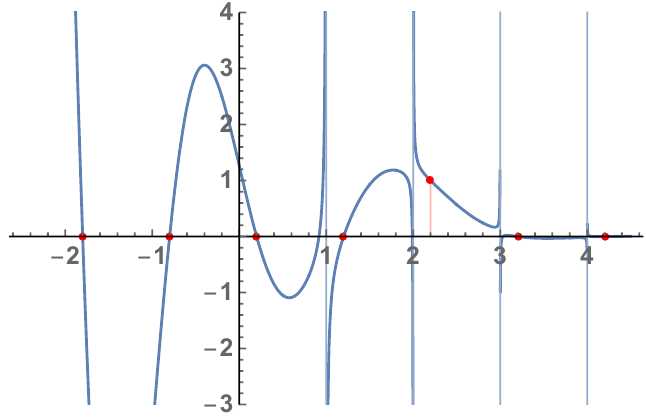
Figure 1 . A plot of J ( C ) ( α, β ) with β = 2 . 2 as a function of (real) α . We observe the kinematic poles at positive integer α . The red dots help to show that J ( C ) ( β + n, β ) = δ n, 0